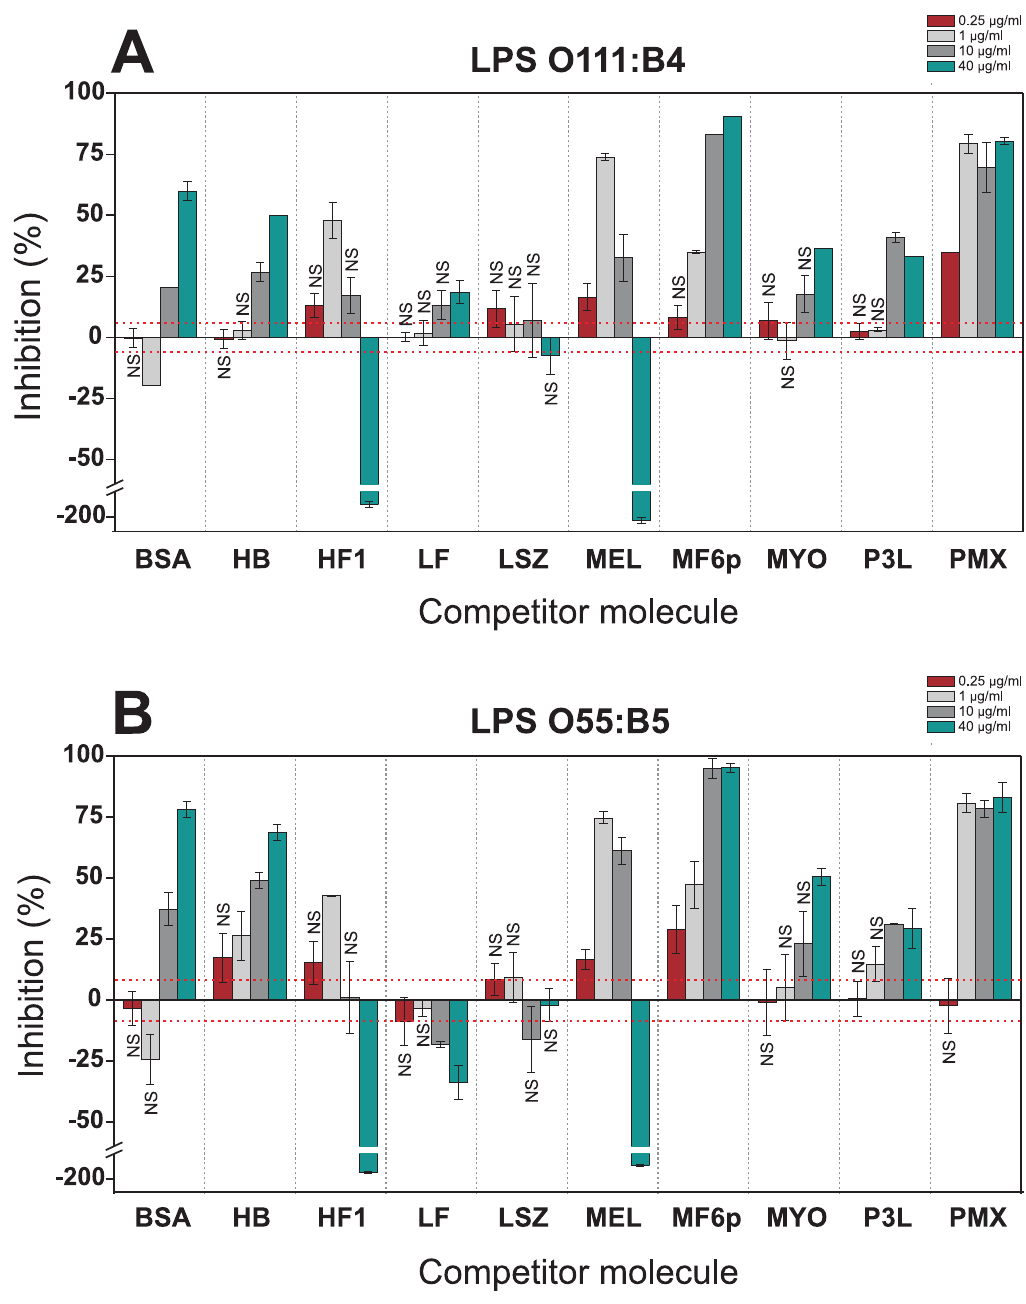
Fig 5. Competitive hCAS-ELISA performed under neutral conditions. FITC-LPSs (5 μ g/ml) from E . coli serotypes O111:B4 (A) and O55:B5 (B) were preincubated with different concentrations of proteins and peptides (40, 10, 1 and 0.25 μ g/ml) in PBS-EDTA (pH 7.2) and added to the wells coated with casein hydrolysate (hCAS). Data are expressed as percentage inhibition of LPS binding to hCAS by the target molecule and are the mean values ± SD of duplicate wells. The average values of the optical density (492 nm) of control wells (without inhibitor) were 0.311 ( ± 0.019, red dashed line) and 0.300 ( ± 0.025, red dashed line) for serotypes O111:B4 and O55:B5, respectively. Differences were considered significant at p < 0.05. NS: not significant. BSA, bovine serum albumin; HB, hemoglobin; HF1, histone f1 fraction; LF, lactoferrin; LSZ, lysozyme; MEL, melittin; MF6p, synthetic FhHDM-1/MF6p; MYO, myoglobin; P3L, A . simplex peptide: MCQCVQKYGTEFCKKRLA; PMX, polymyxin B.